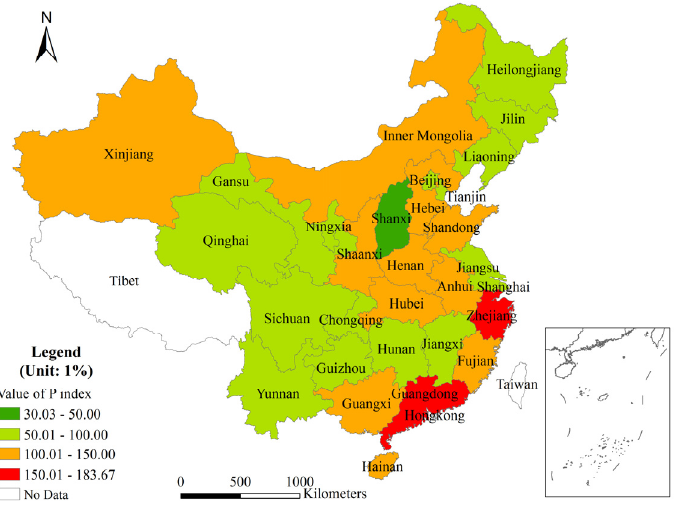
Figure 10. Distribution of P index.